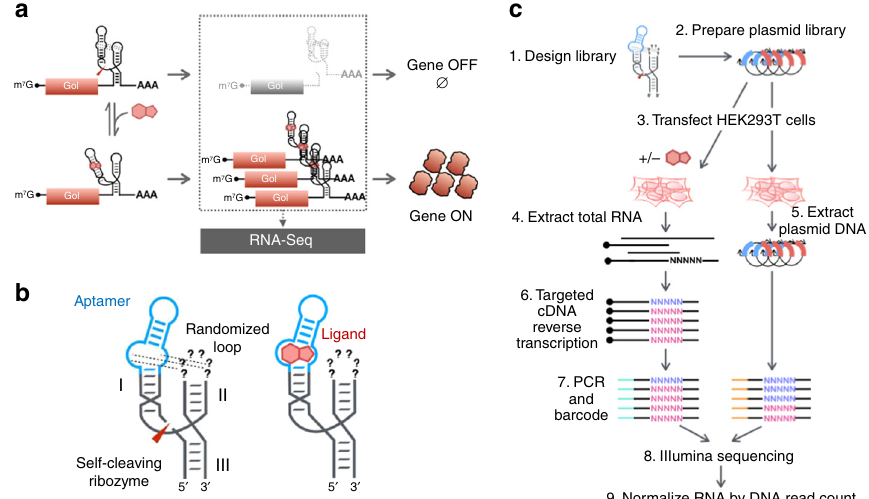
Fig. 1 A high-throughput, quantitative pipeline for engineering ribozyme switches. a A schematic illustrating the mechanism by which ribozyme switches achieve conditional gene expression regulation. In the absence of ligand, the switch undergoes self-cleavage, destabilizing the transcript and resulting in low protein expression. Ligand binding to the switch interferes with the loop – loop tertiary interactions of the ribozyme to inhibit self-cleavage, in turn stabilizing the transcript and leading to increased protein expression. The differential mRNA levels resulting from ribozyme switch activity can be assayed with RNA-Seq. b Schematic of the architecture of a ribozyme switch. The switch comprises a ribozyme actuator domain (black) and a ligand-sensing aptamer domain (blue). In the illustrated library design, an aptamer is grafted onto stem I of the hammerhead ribozyme and 4 – 6 bases of stem loop II are randomized. The library is screened for loop sequences that interact with the integrated aptamer to enable ribozyme self-cleavage, while allowing ligand binding at the aptamer to disrupt the tertiary interactions and inhibit cleavage. c RNA-Seq work fl ow for measuring differential mRNA expression levels associated with a ribozyme switch